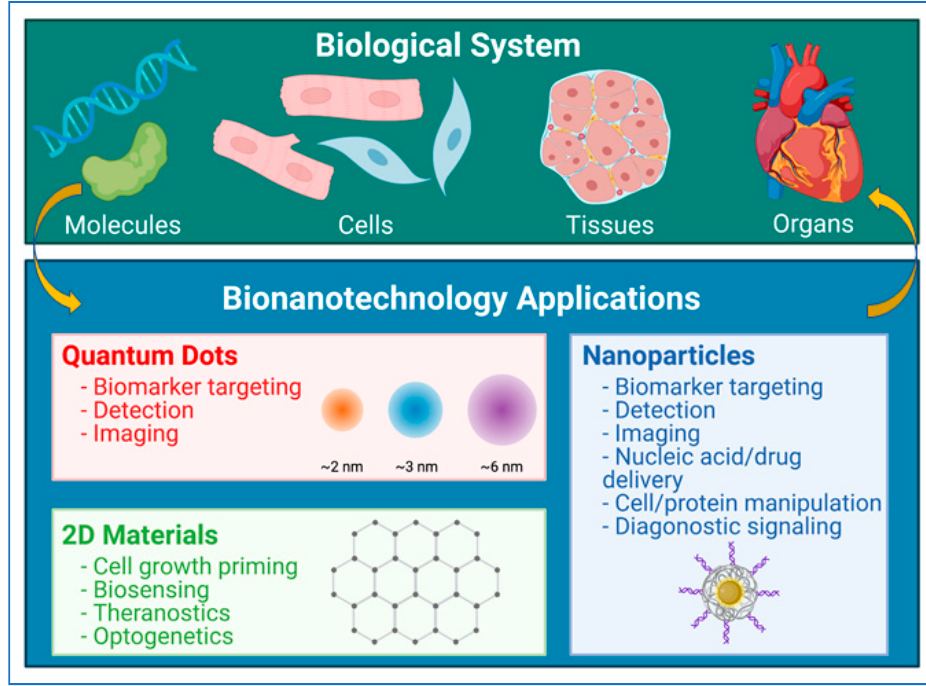
Figure 2. Bionanotechnology applications in biological system. Various applications of nanotechnology in biological research and medicine. Figure generated using BioRender.